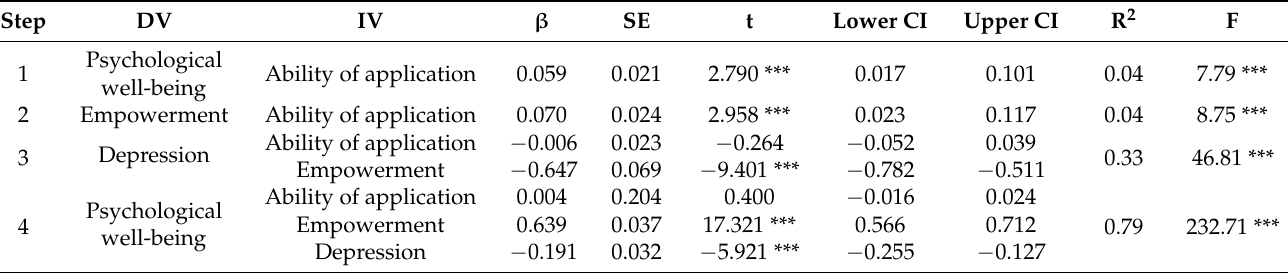
Table 4. Mediation effect of empowerment and